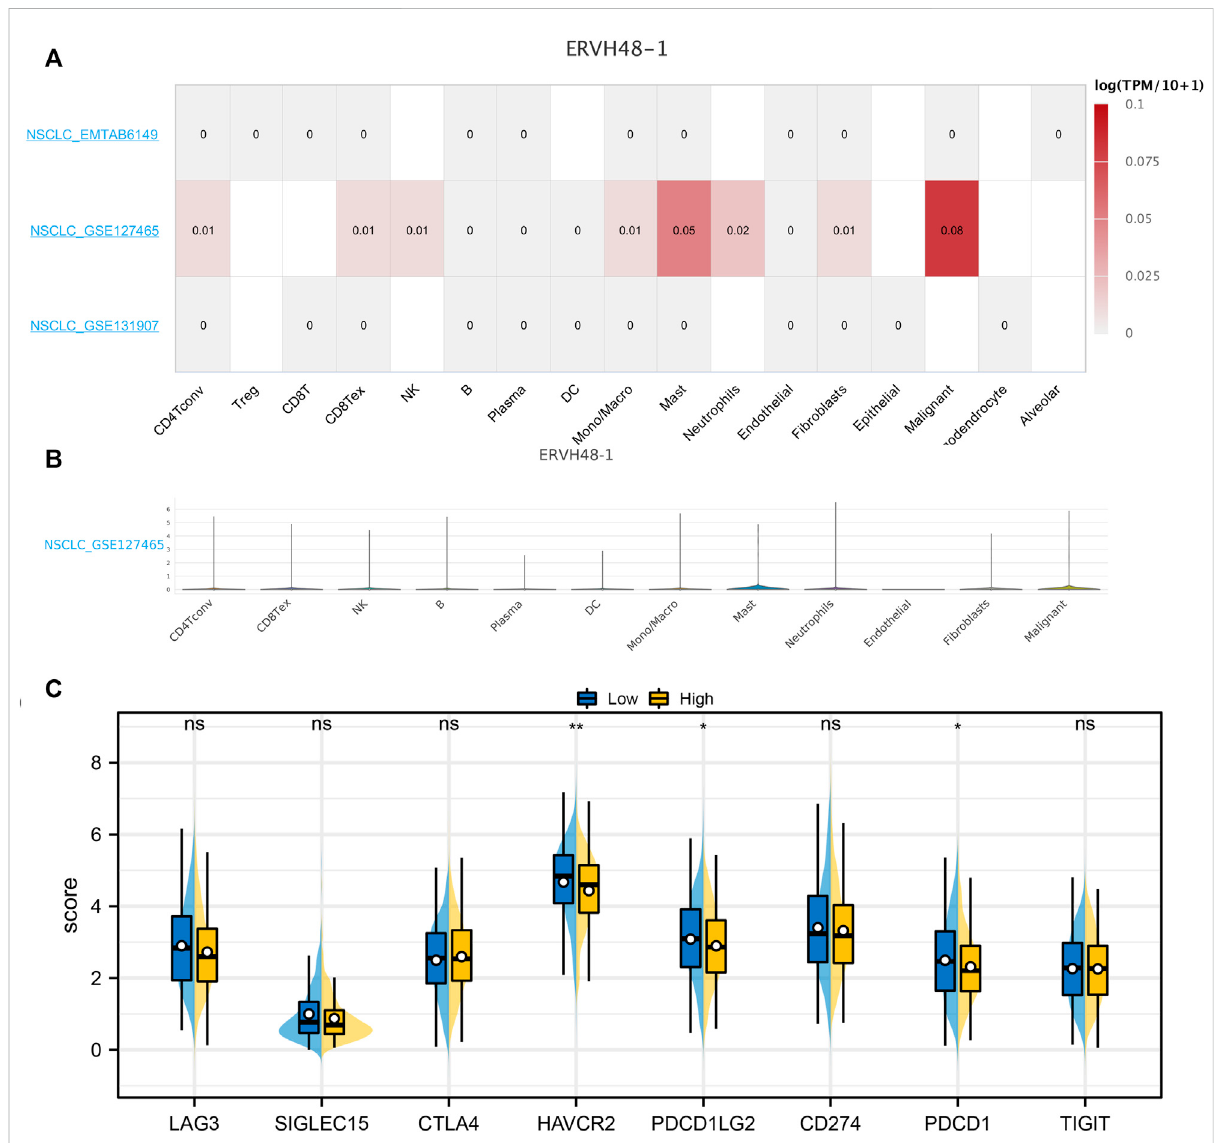
FIGURE 7 Single-cell analysis of ERVH48-1. Notes: (A,B) : The ERVH48-1 expression in different cell subgroups; (C) : The level of key immune checkpoints in patients with high and low logistics